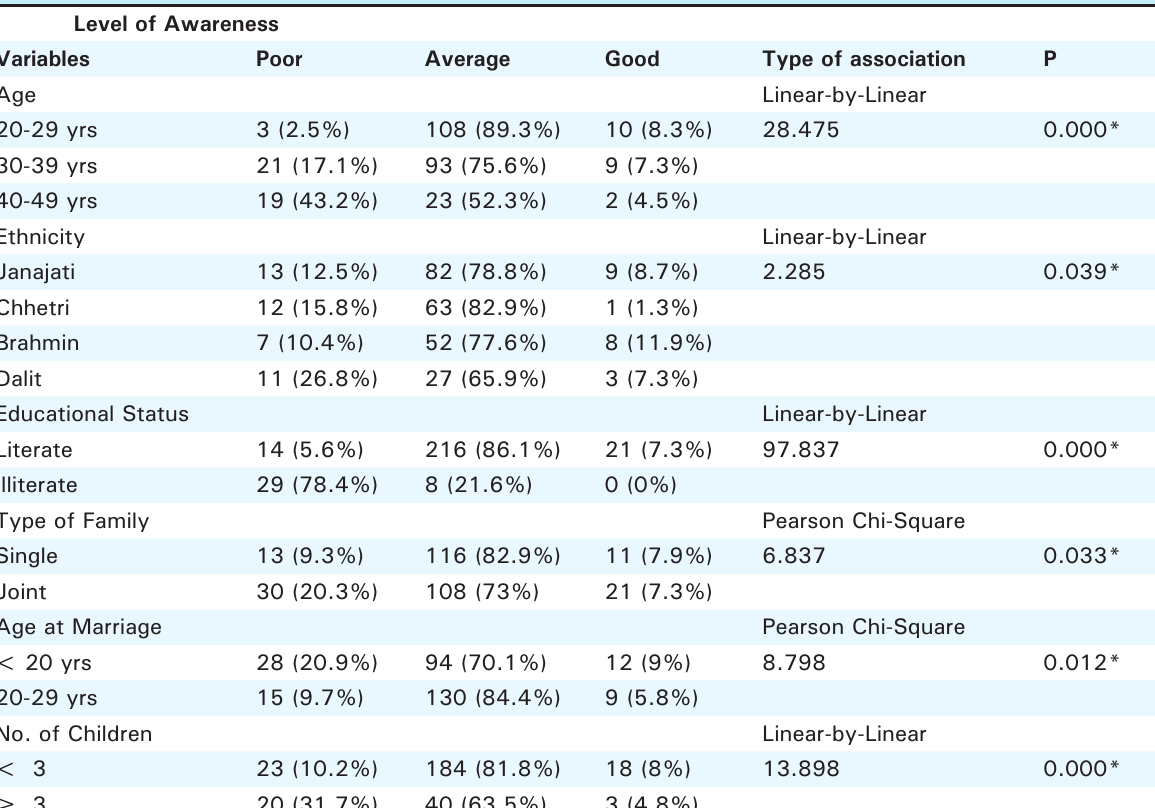
Table 4. Association of Awareness Level of Mothers with Age, Ethnicity and Religion. Level of